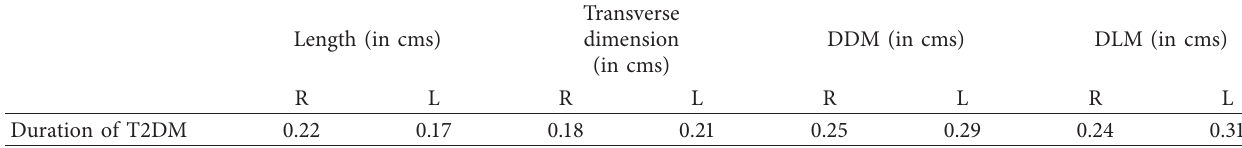
Table 3: Correlation between ultrasonographic measurements of parotid glands of study subjects (diabetic mellitus type 2) with HbA 1C . Transverse Length (in cms) DLM (in cms) DDM (in cms) dimension (in cms) R L R L R L R L Hb1Ac 0.02 0.21 0.09 0.15 0.19 0.37 0.19